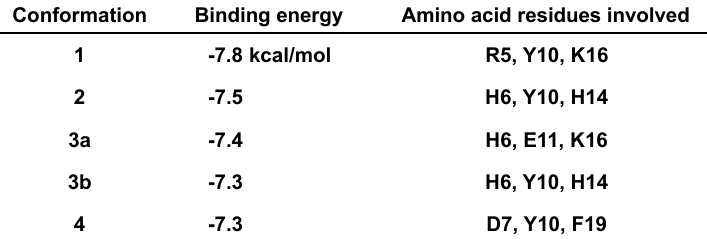
Figure 3. Computational molecular docking analysis (CMDA) of the EGCG and A β complex [70]. The possible pose conformation of the EGCG-A β complex with the highest frequency is shown with the involvement of Arg5, Tyr10, and Lys16. Binding energy and the amino acid residues involved in the top five pose conformations with a high frequency are also shown. Reproduced in part with permission of the publisher, Proceedings of the National Academy of Sciences of the United States of America. doi:10.1073/pnas.12203261.